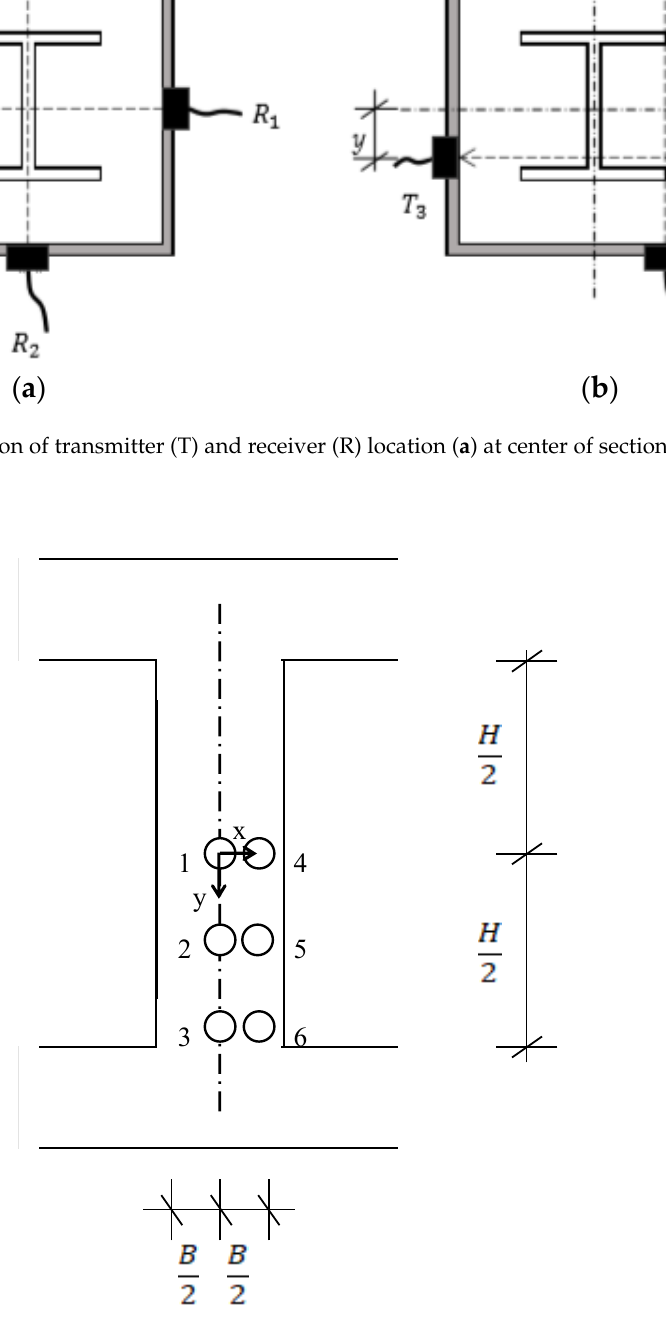
Figure 2. Possible locations along column to place a probe. H: height of column; B: side dimension of column.